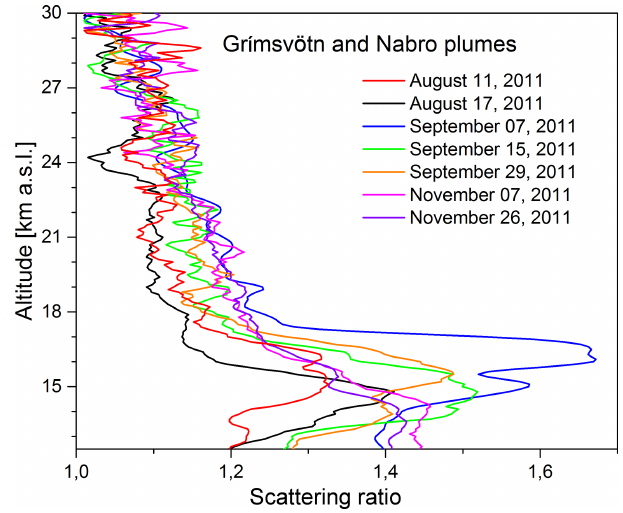
Figure 13. Detection of the Grímsvötn (Iceland) and Nabro (Er- itrea) volcanic plumes in the stratosphere over Tomsk. The volca- noes started to erupt on 21 May and 13 June 2011,